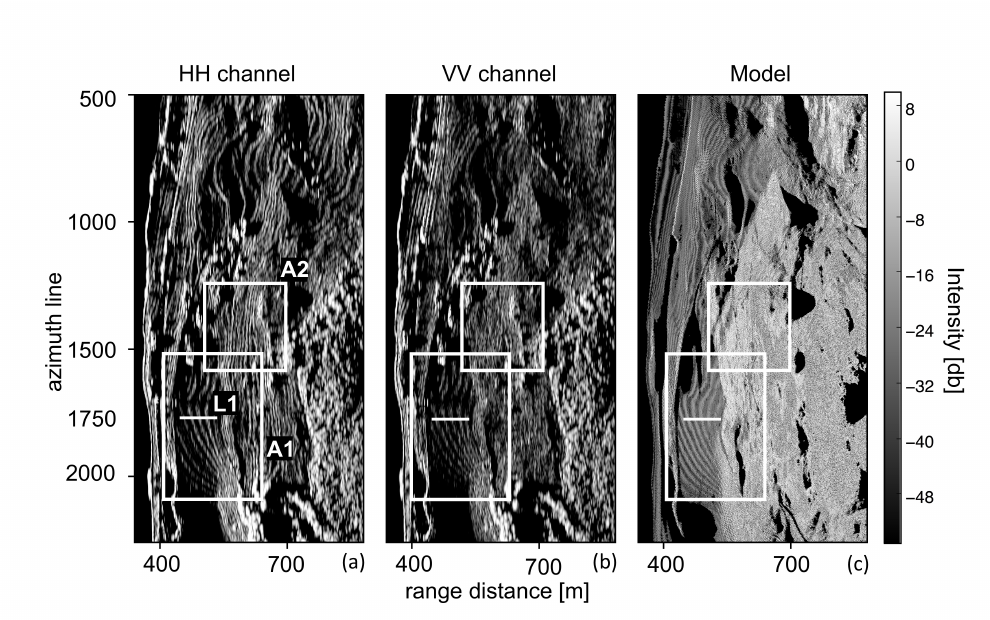
Figure 5. Radar backscatter images showing an MPI pattern at the Dorfberg test site in ( a ) horizontal and ( b ) vertical polarisation compared with ( c ) the modelled MPI. Area A1 highlights an area with a strong, low frequency MPI signal that are well visible in both polarisations and the model. Area A2 shows a higher frequency signal due to a steeper slope that are visible in the backscatter intensity image of the horizontal wave polarisation but hard to discern in the vertical polarisation and not present in the model. The white line corresponds to the central azimuth line used for the computation shown in Figure 6.